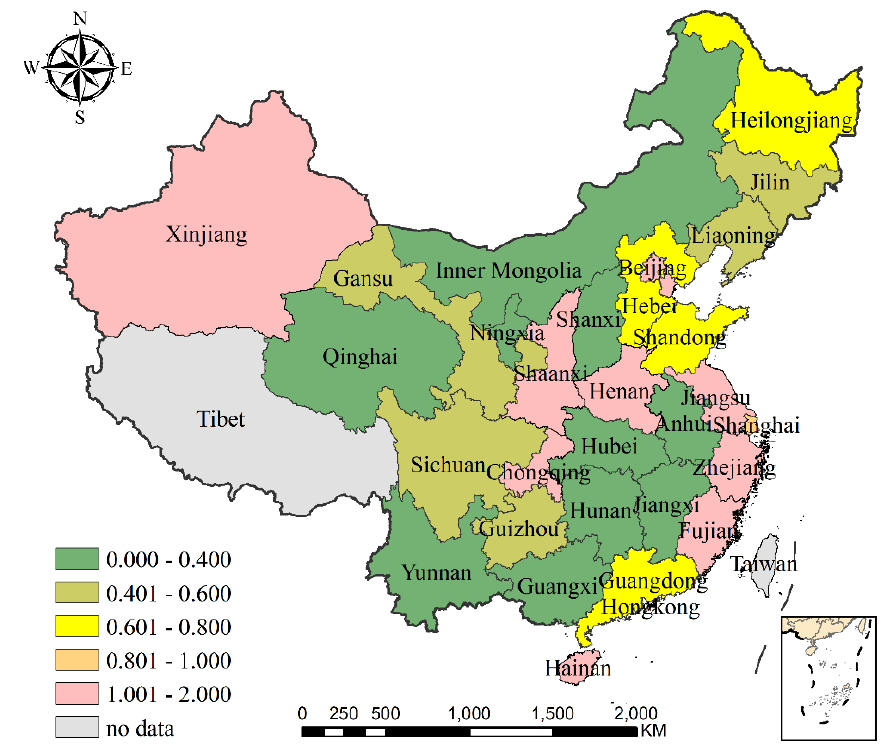
Figure 4. Agricultural water use efficiency of 30 provinces in China in 2019.